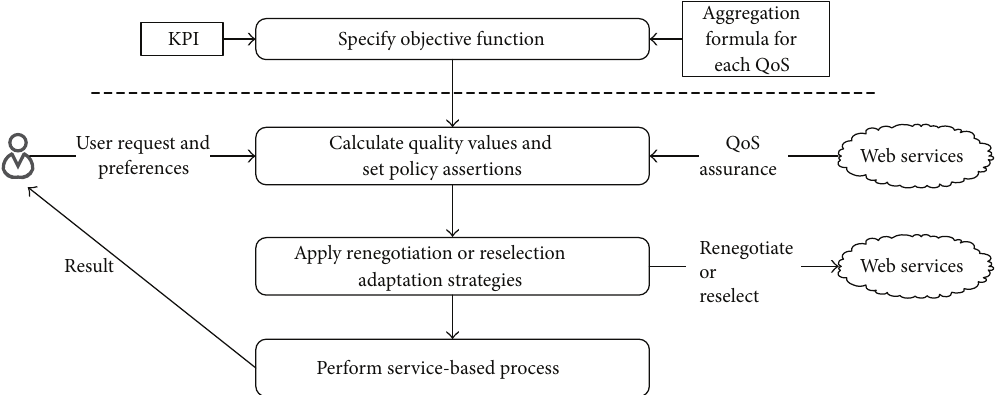
Figure 3: The process of adapting service-based process to user’s preferences.